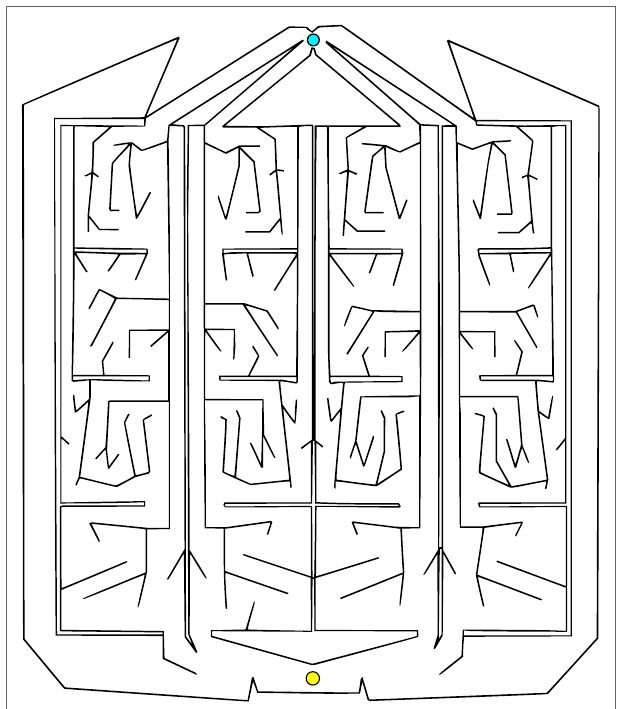
FigUre 3 | symmetric gauntlet . Individuals start at the point at the bottom and must navigate to the goal at the top of the maze. Each leg of the maze is an approximate mirror image of the neighboring legs (thus, all paths through the maze are similarly difficult to achieve). The presence of multiple legs allows various different driving strategies to be successful.